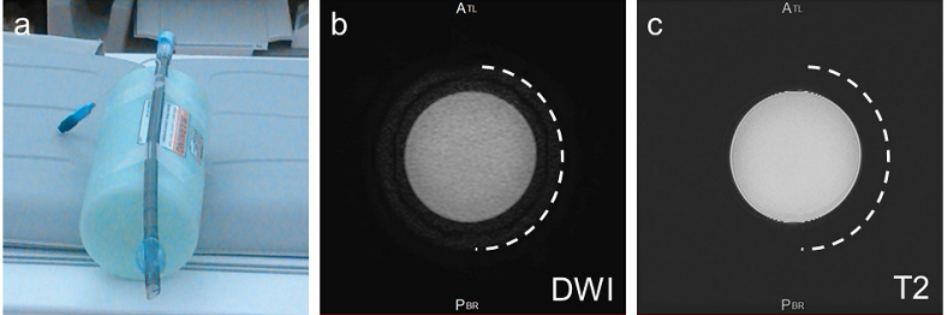
Figure 3. Comparison of the images of metal wires in the phantom on MRI (3.0-Tesla). To evaluate the susceptibility artifacts of various metal wires, axial DWI ( a – d ) and T2-weighted ( e – h ) MRI of helical metal wires was performed: ( a , e ) Ti alloy (Ti-6Al-4V ELI, Ø 0.21 mm) used in our reinforced endotracheal tube, ( b , f ) pure Ti (Ø 0.1 mm), ( c , g ) Ni-Ti alloy (Ni-Ti, Ø 0.1 mm), and ( d , h ) SS (SUS304, Ø 0.1 mm).